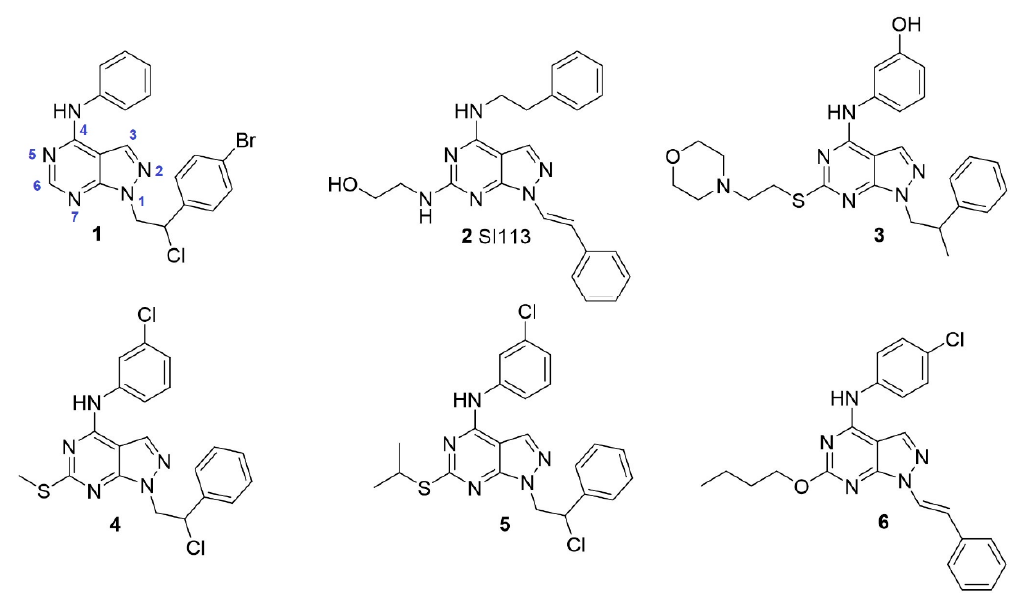
Figure 1. Structure of selected pyrazolo[3,4- d ]pyrimidines 1 – 6 .